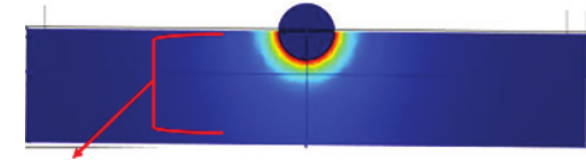
Figure 8: A 2D model showing the electric field inside the silicon bulk along the x-z plane